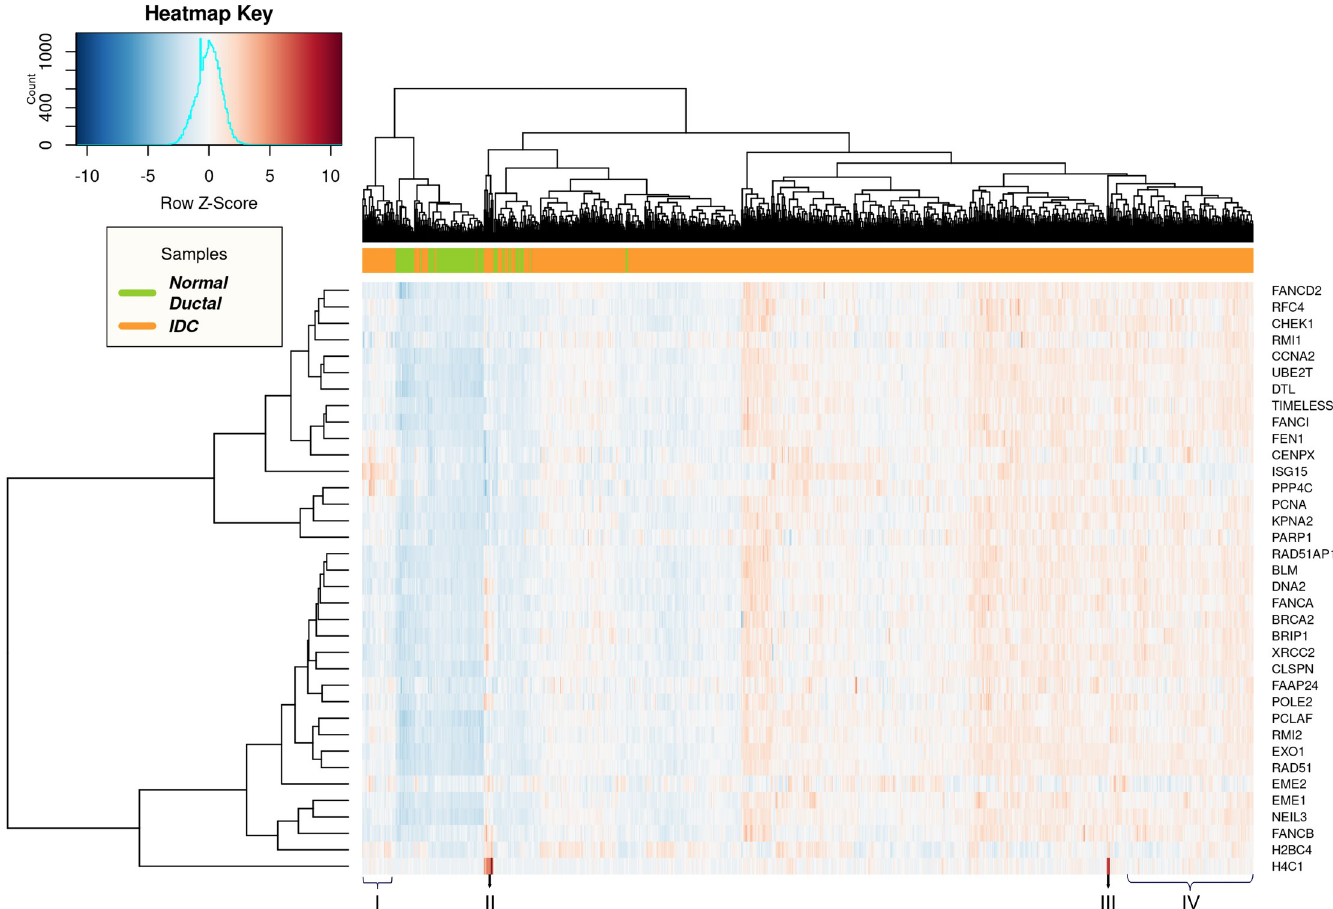
Fig 4. Heatmap representing the 36 DNA repair DEGs in normal_ductal vs IDC. Normal Ductal/normal_ductal (Green) and IDC (Orange).